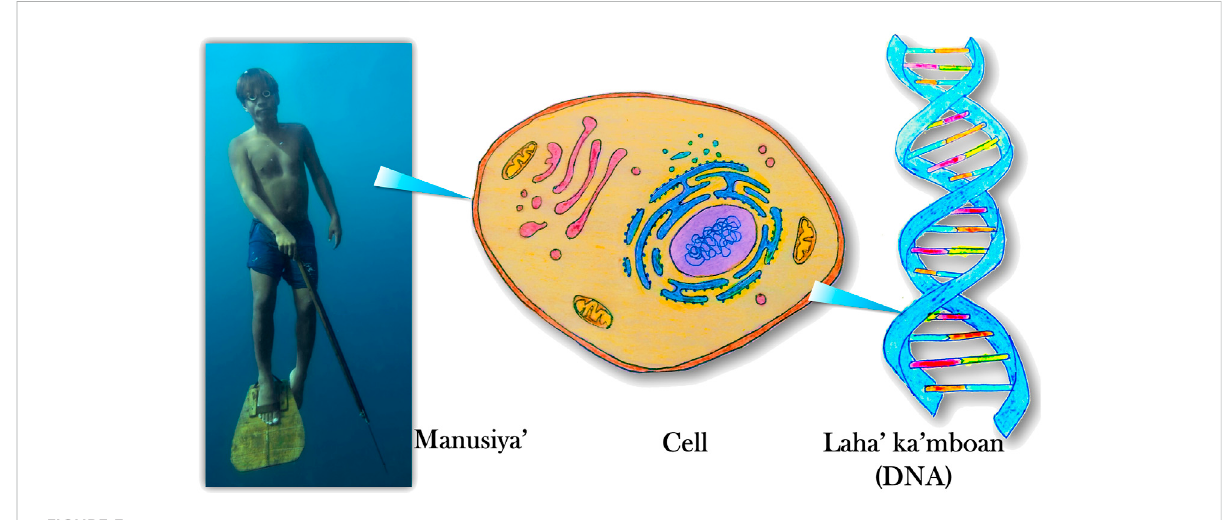
FIGURE 3 Oneofthevisualaidsusedduringgrouporientationsexplainshowhumans( manusiya ’ )aremadeupofcellscontainingDNA( laha ’ ka ’ mboan lit. Blood of ancestors). Illustrated by Jacob Barbosa. Photograph from Jacob